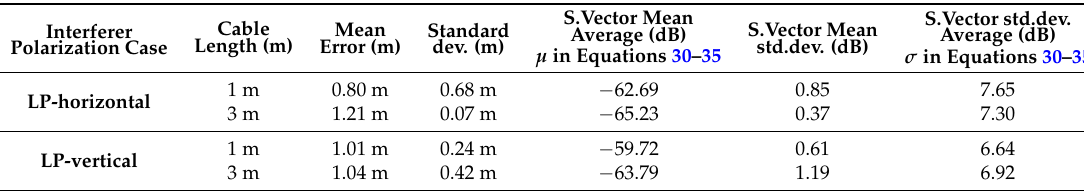
Table 7. Static interferer localization results over 50